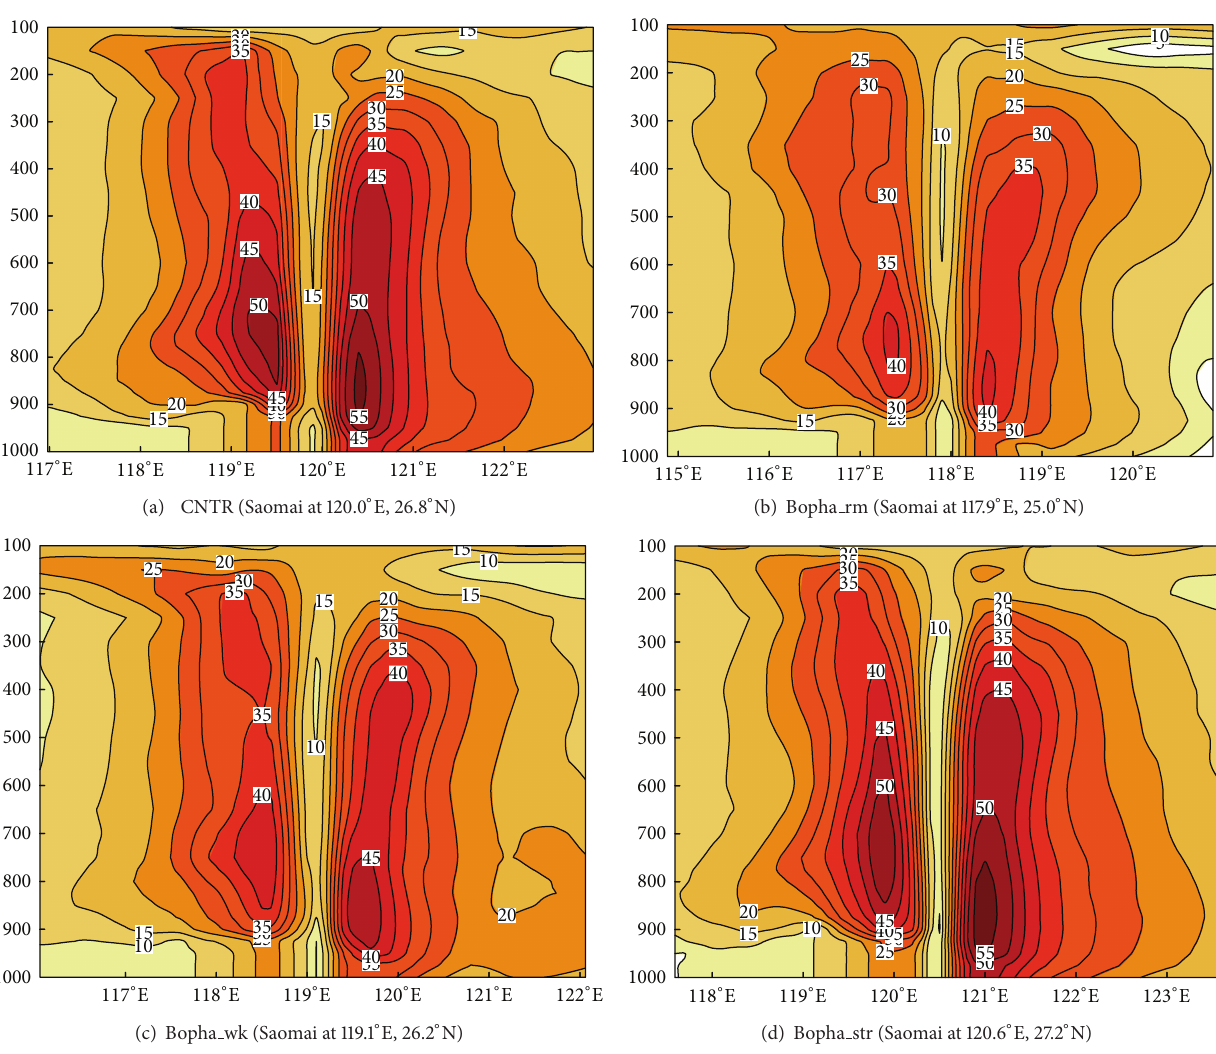
Figure 7: Same as Figure 6 except at 1800 UTC 10 August,